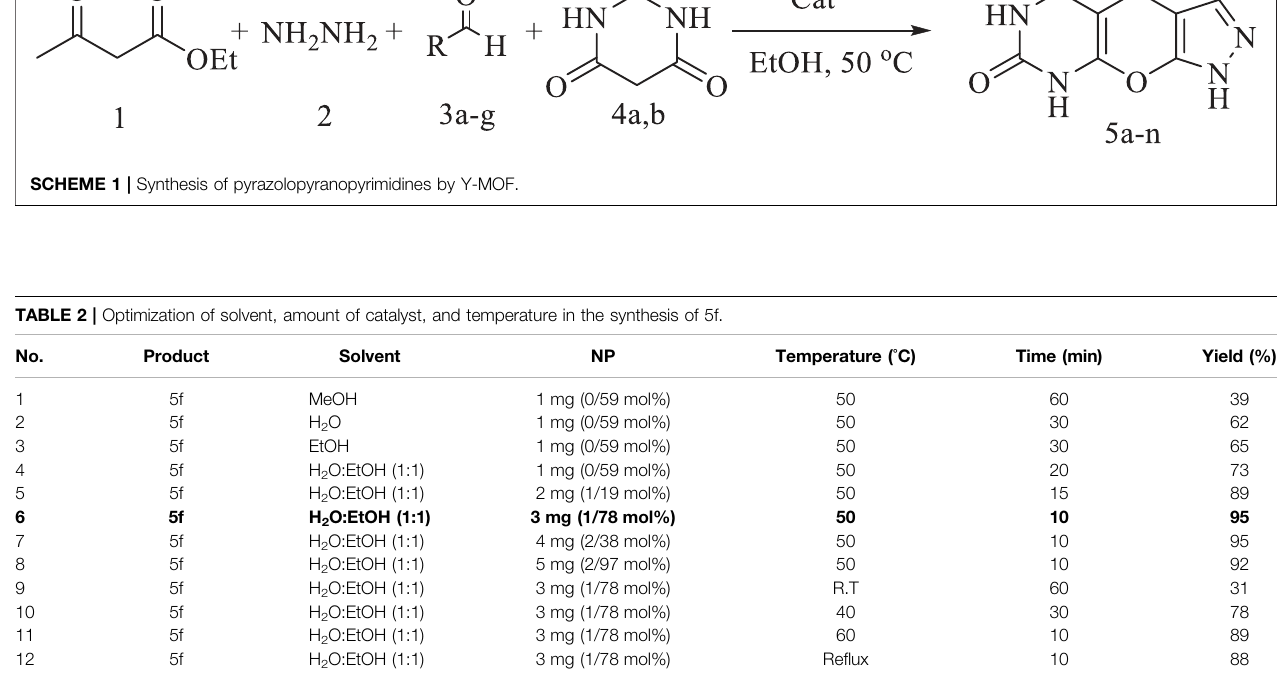
Frontiers in Chemistry |